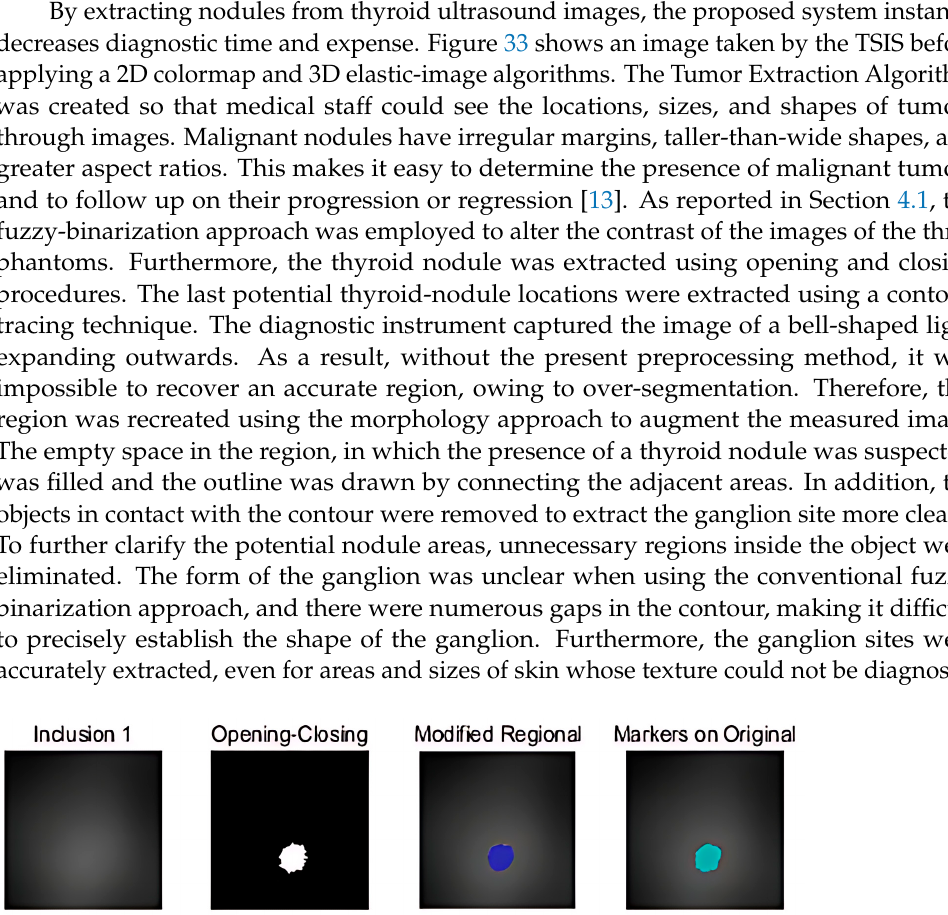
Figure 33. Thyroid-tumor-extraction algorithm. 4.3. Conclusions We designed and tested a new TSIS capable of characterizing intratissue inclusions in this study. The thyroid tissue was exposed to pressure during scanning using the TIR principle, which caused a change in its elasticity. Using the TIR principle, the light scat- tering was photographed to yield high-resolution tactile images inside a multilayer opti- cal waveguide mimicking human skin. Utilizing wave optics, the TIR was shown to be feasible and revealed clear tactile images when the multilayer silicon PDMS was crushed. As the scattered light was immediately collected by the CCD camera, the tactile resolution of the probe was determined by the camera’s resolution. The TSIS was confirmed experi- mentally using tissue phantoms with various inclusions for each condition. Unusual